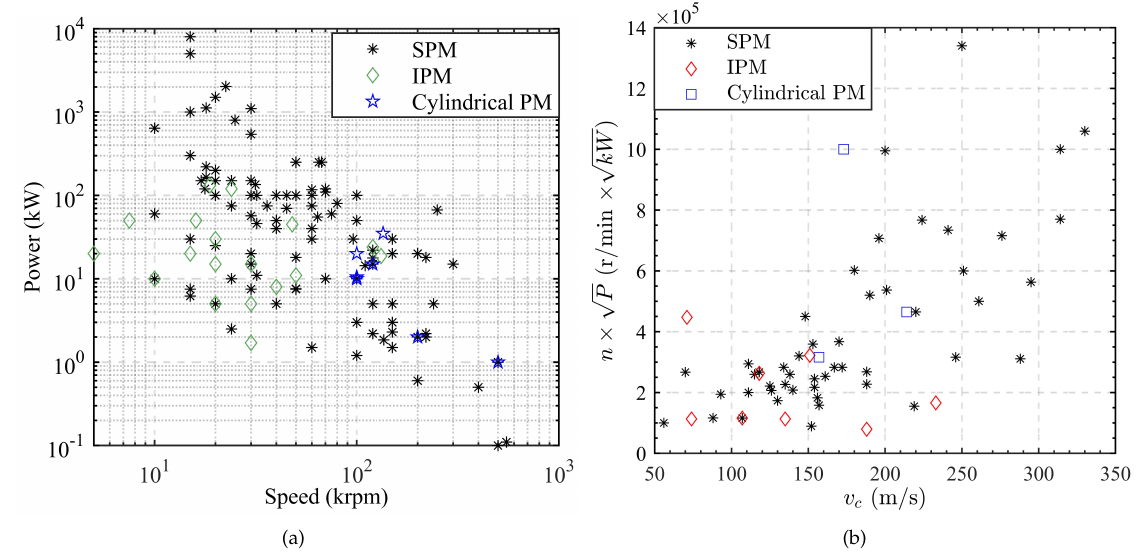
Figure 3. Power and speed distribution of high-speed motor: ( a ) Speed and power distribution of high-speed PM motors with different structures; ( b ) Distribution of v c and r/min PM